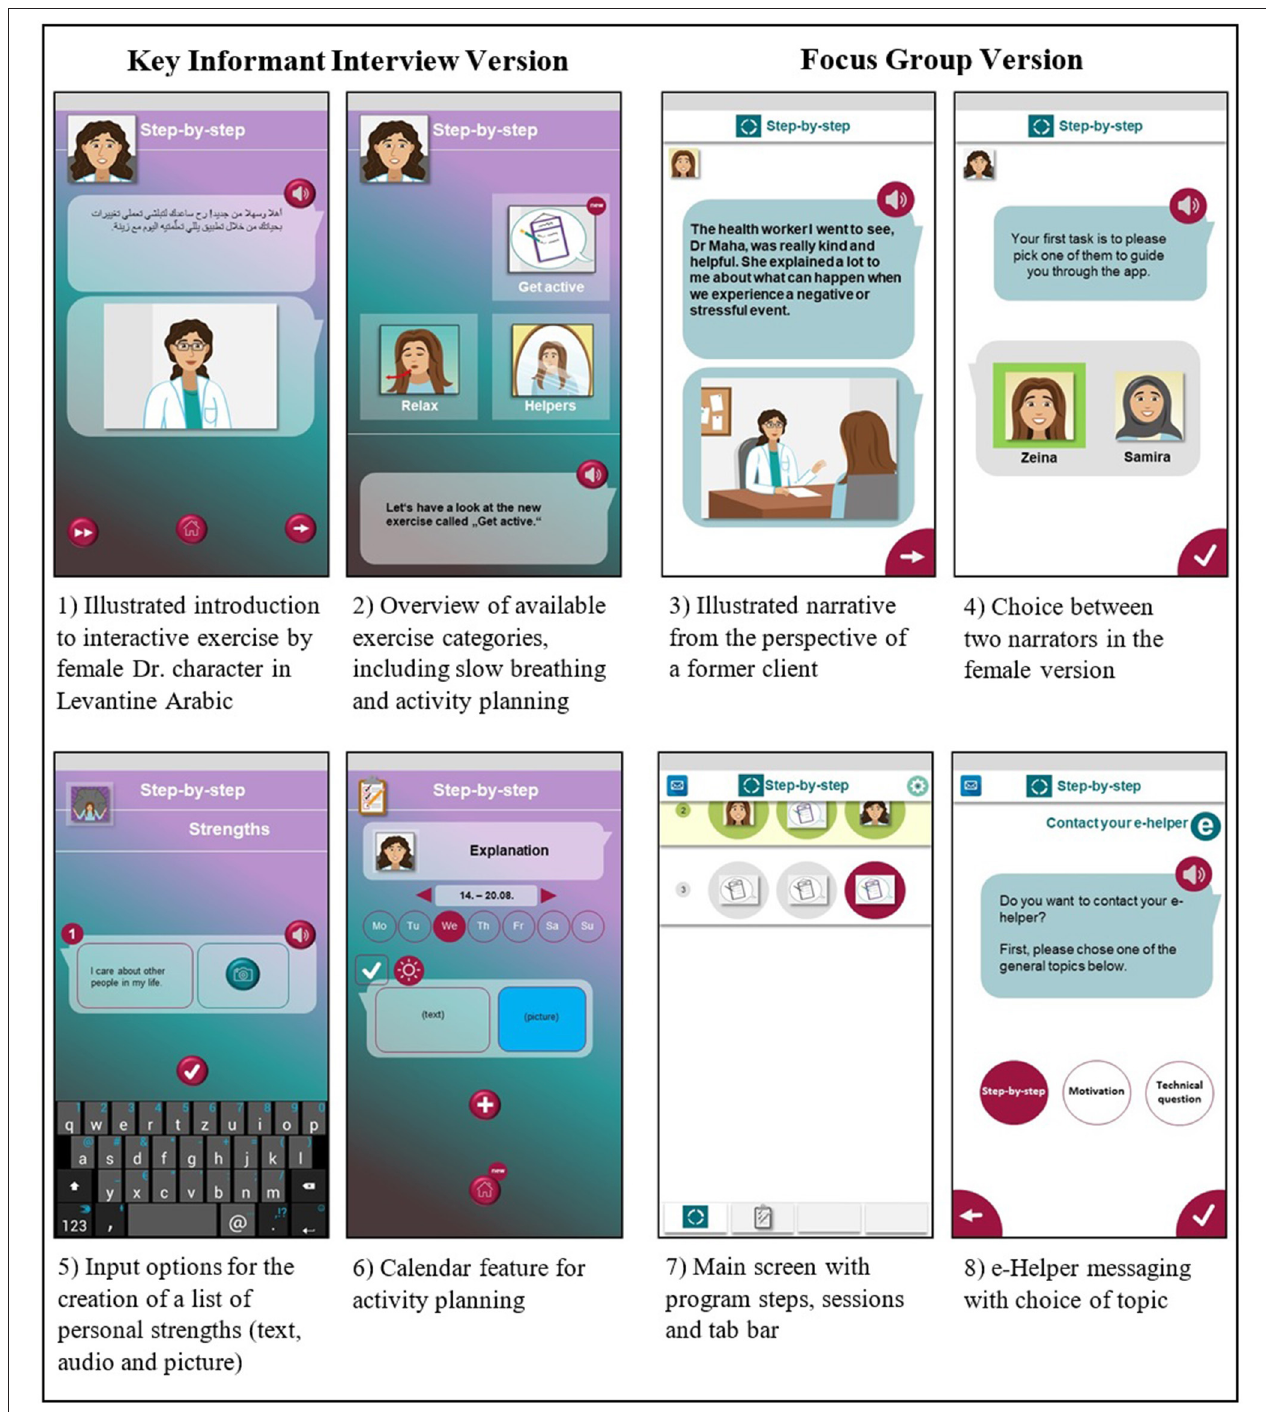
FIGURE 1 | Selected prototype screens (text on screen 3 and illustrations depicting Step-by-Step characters and icons are adapted and reproduced with permission from WHO).